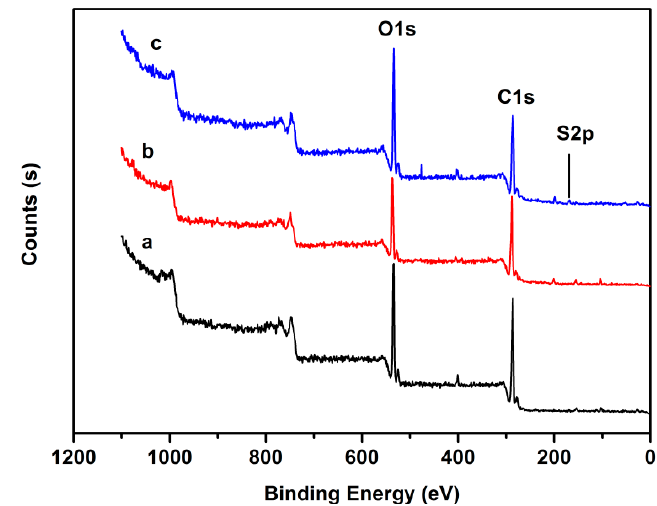
Figure 4. XPS spectra of a, chitosan; b, O -CMCS; and c, chitosan-based biopolymer dye.